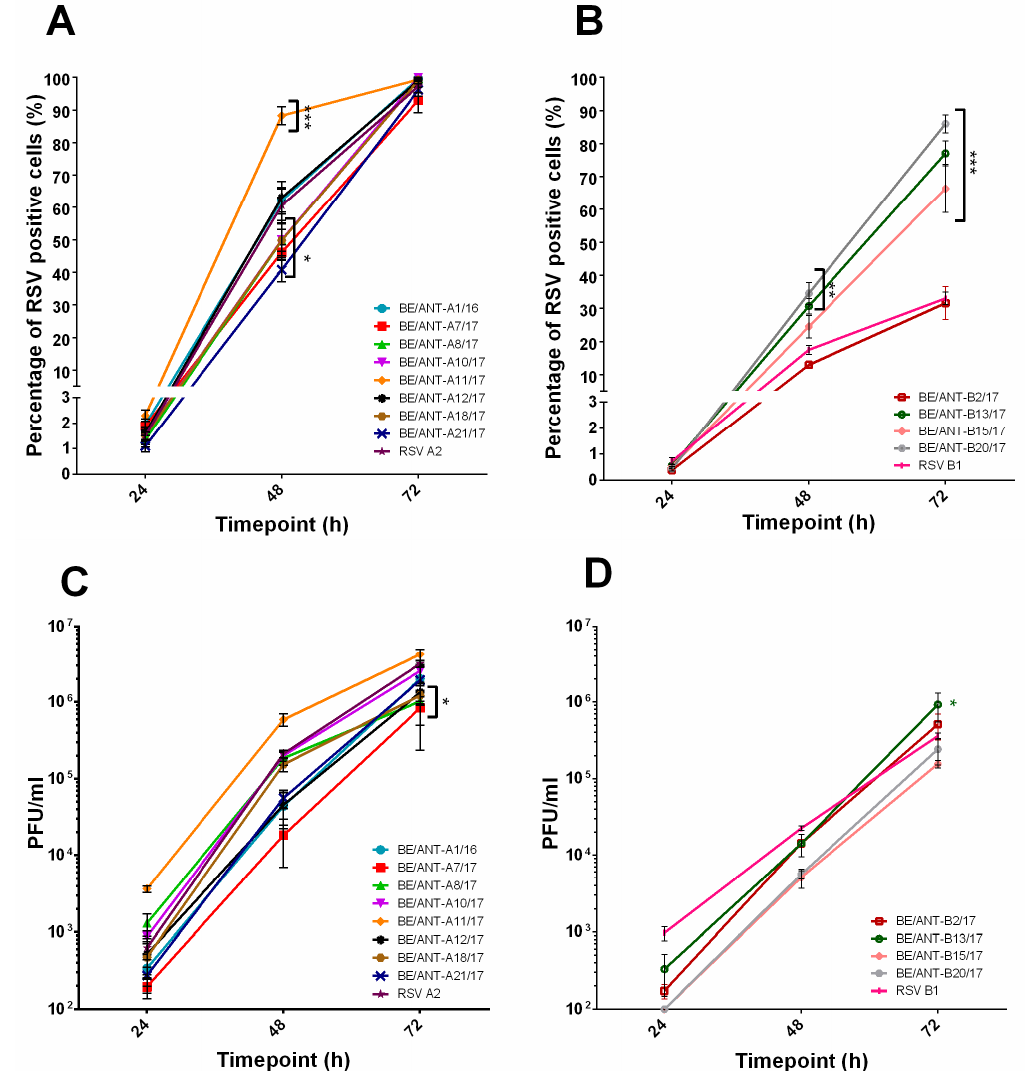
Figure 2. Replication kinetics and infectious virus production in HEp-2 cells. ( A , B ) HEp-2 cells were infected with clinical isolates and RSV reference strains A2 and B1. Cultures were fixed after 24 h, 48 h and 72 h, permeabilized and stained with polyclonal antibody (pAb) goat-anti-RSV antibody and AF488 donkey-anti-goat (IgG). Nuclei were visualized with DAPI and cultures were analysed with fluorescence microscopy. RSV positive cells were counted and calculated to the total number of nuclei to reach a percentage of RSV infected cells. ( A ) Replication kinetics of RSV-A clinical isolates and ( B ) Replication kinetics of RSV-B clinical isolates. ( C , D ) HEp-2 cells were infected with clinical isolates and RSV reference strains A2 and B1. After 24 h, 48 h and 72 h, supernatants were collected and used for quantification by conventional plaque assay. Data represents mean values ± SEM ( n = 3), significant di ff erences compared to the reference strains are indicated by * p < 0.05; *** p < 0.001 (two-way ANOVA).